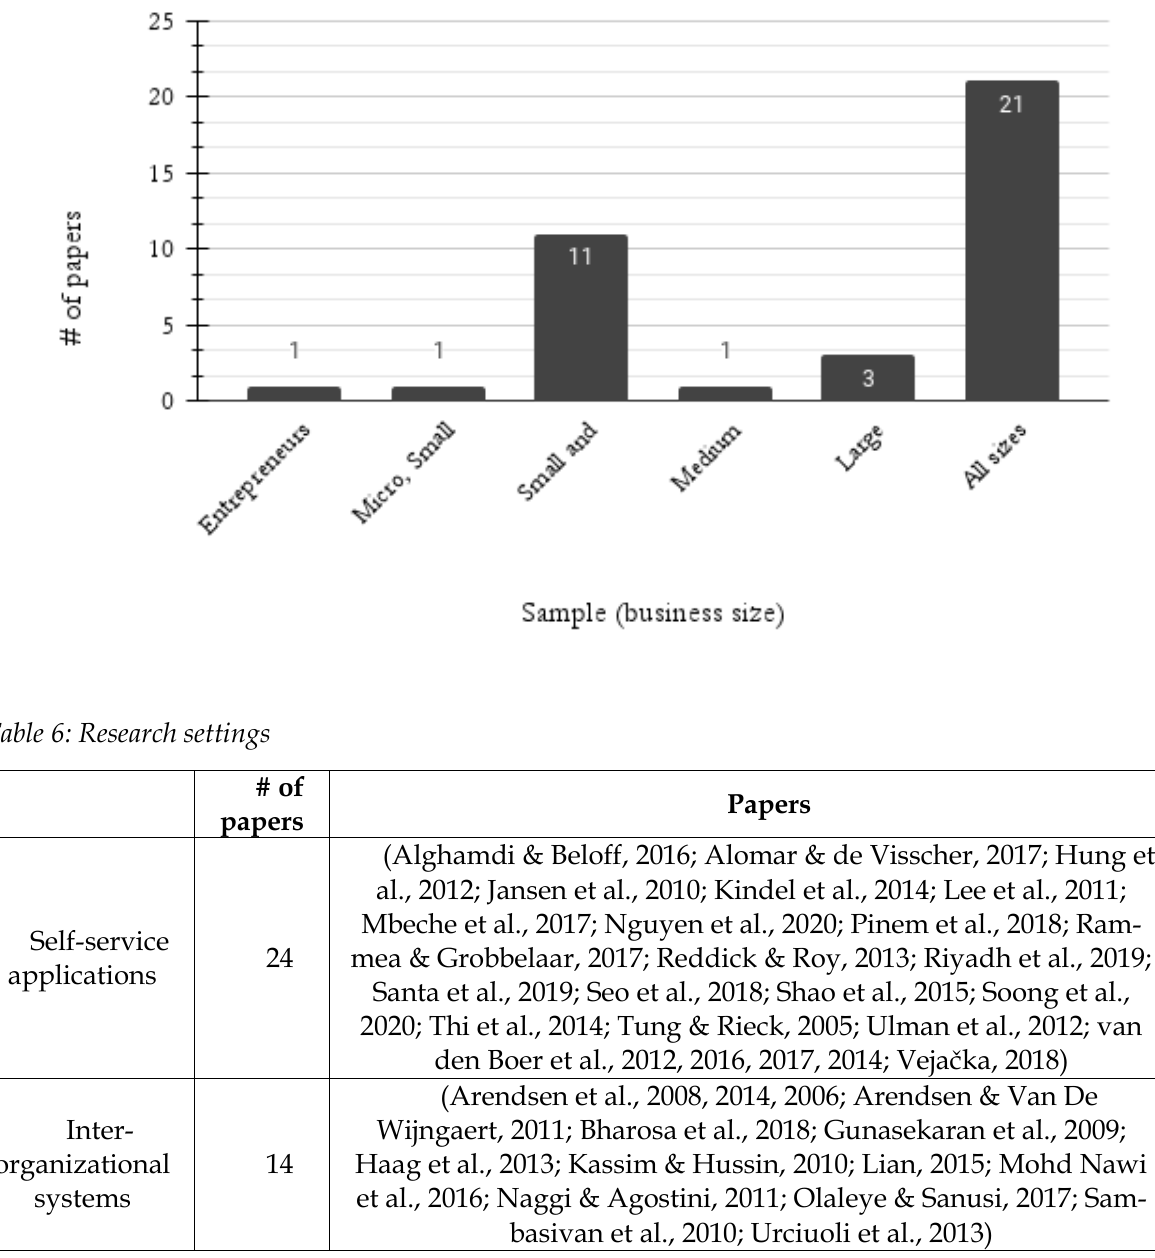
Figure 2: Business size vs number of papers